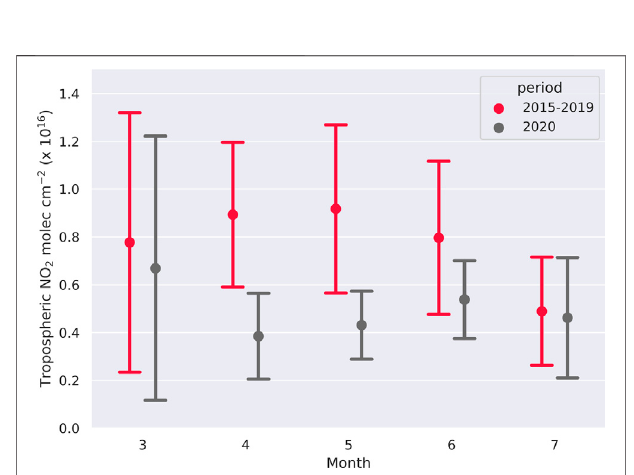
FIGURE3| SatelliteobservationsoftroposphericcolumnNO 2 overtheIndianregionduringthemonthscorrespondingtoCOVID-19lockdownandunlockphases (March, April, May, June, July) during 2020 (B) and comparison to 2019 (A) . (C) shows the monthly difference between 2020 and 2019.